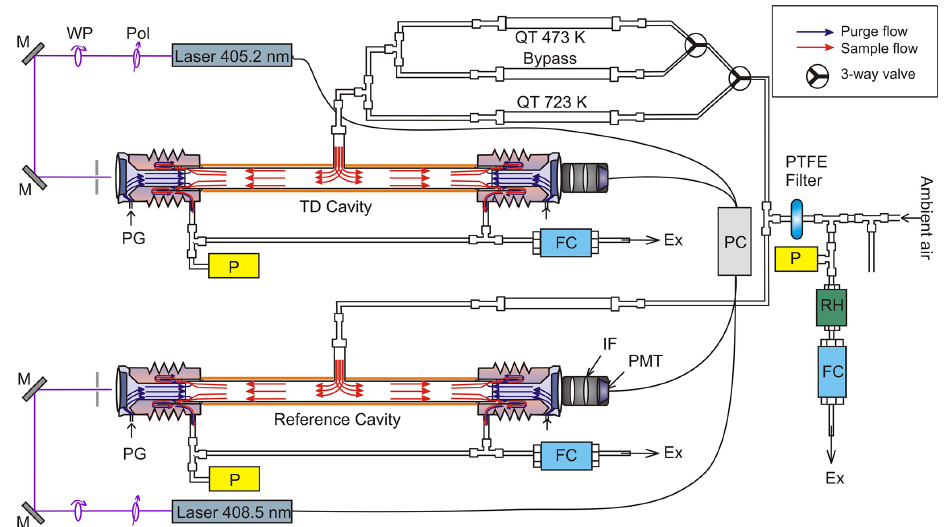
Figure 1. Schematic diagram of the two cavities (reference and TD) and associated inlets (quartz tubes at ambient temperature, 473 or 723K). The reference cavity samples continuously via a quartz tube at ambient temperature, the TD cavity samples sequentially from quartz tubing at ambient temperature, 473 or 723K. Both cavities are held at 308K and at constant pressure (usually 800mbar). M: mirror, WP: quarter-wave plate, Pol: polariser, QT: quartz tubing, P: pressure transducer, FC: mass flow controller, PC: computer, RH: relative humidity and temperature sensor, IF: interference filter, PMT: photomultiplier, PG: purge gas, Ex: exhaust.